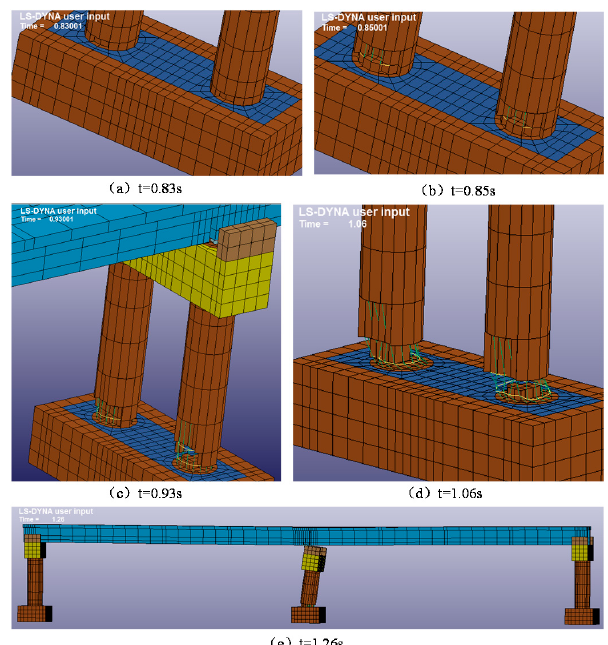
Figure 25. Longitudinal collapse mode of the CLUC system under the El Centro wave.